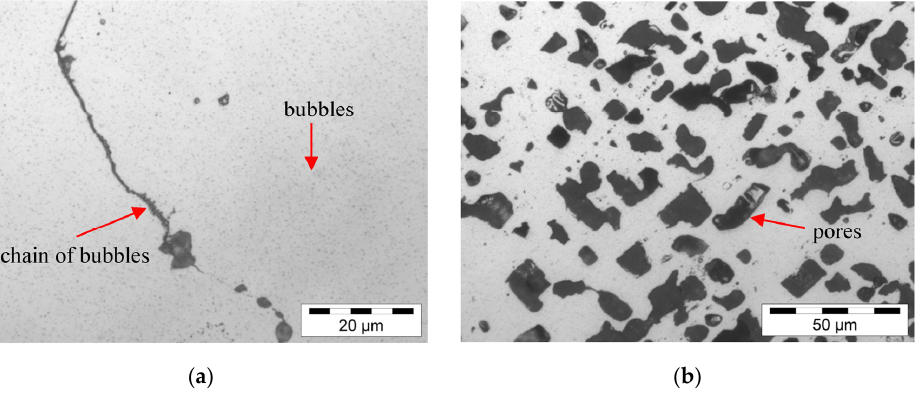
Figure 9. Small bubbles ( a ) and big pores ( b ) in microstructure of cast Be irradiated at 517 °C to F = 1.51 ∙ 10 22 cm − 2 (E > 1 MeV) and 750 °C to neutron fluence of 1.82 ∙ 10 22 cm − 2 (E > 1 MeV), accordingly F = 1.51 · 10 22 cm − 2 (E > 1 MeV) and 750 ◦ C to neutron fluence of 1.82 · 10 22 cm − 2 (E > 1 MeV), (optical microscopy).